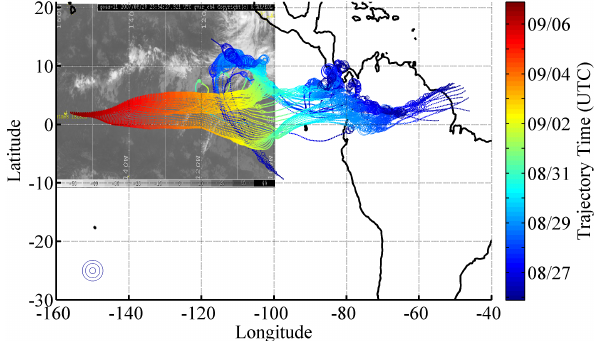
Fig. 10: As Figure 7 but for Case Study II. Trajectories are overlaid on a GOES IR image from 28 August, 23:54 UTC.